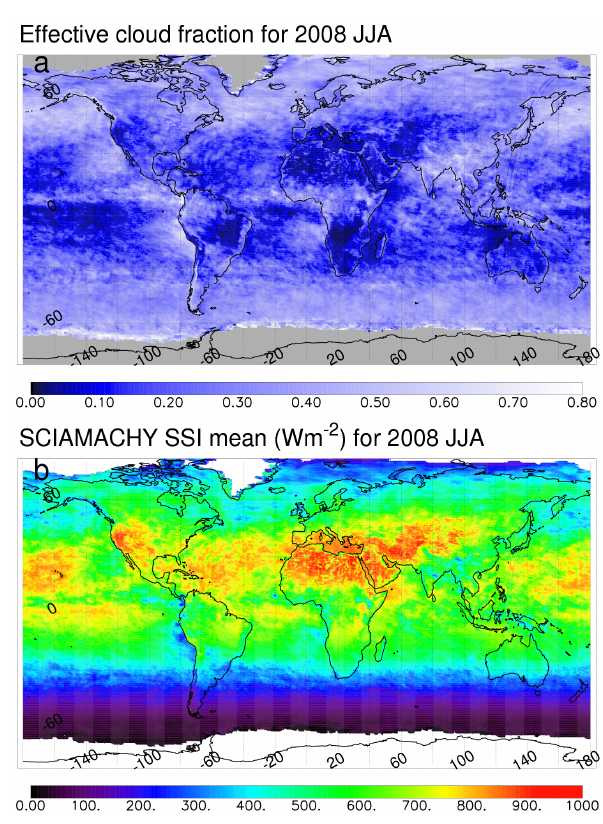
Figure 1. Flowchart of the FRESCO surface solar irradiance (SSI) algorithm. 2